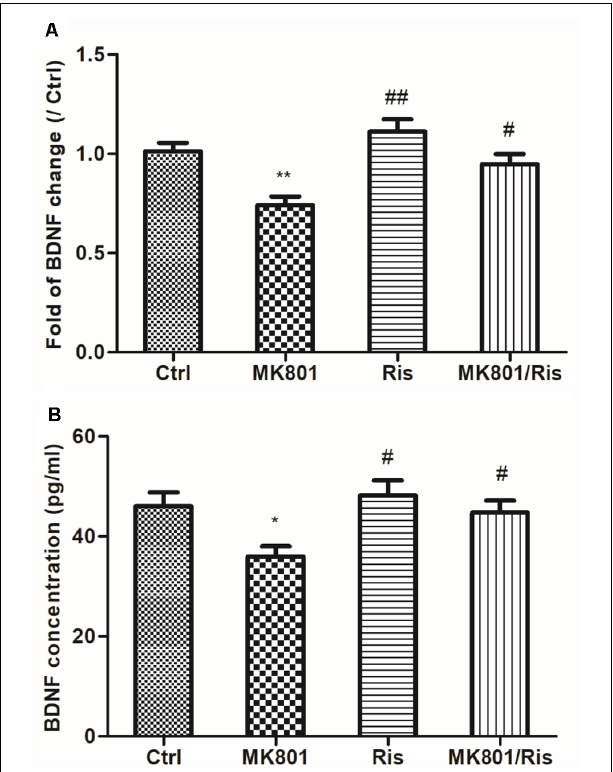
FIGURE 2 | Risperidone reverses MK801-induced decreases in BDNF mRNA expression and protein secretion in hippocampal neurons. (A,B) Cultured neurons were treated with or without 20 µ M MK801 for 2 h; the culture medium was then replaced by a fresh medium with or without 10 µ M risperidone for 24 h. BDNF mRNA and protein levels in cell lysates and culture supernatant were evaluated by quantitative real-time PCR (A) and ELISA (B) , respectively. Densitometric values are expressed as the mean ± SEM of three independent experiments. ∗ P < 0.05, ∗∗ P < 0.01 vs. control group; # P < 0.05, ## P < 0.01 vs. MK801 group.